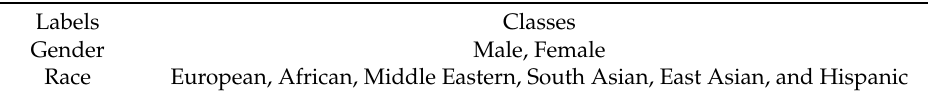
Table 1. Facial Attributes and